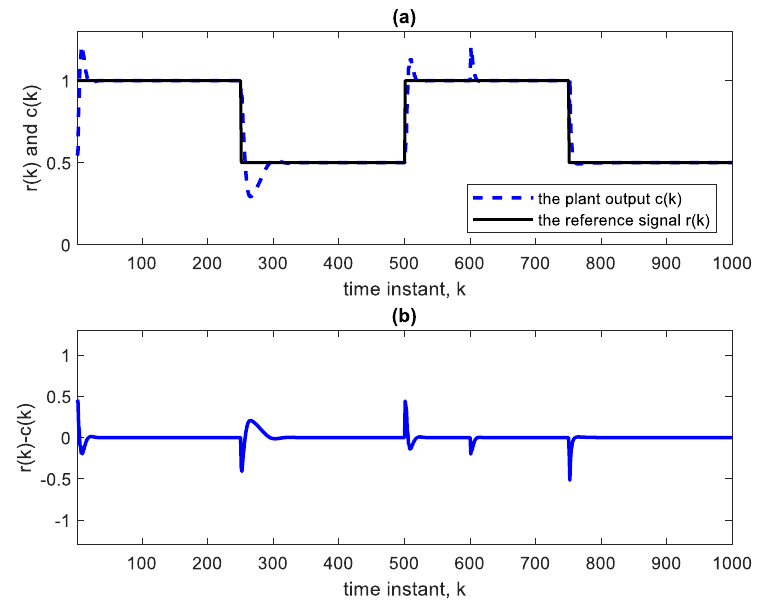
Figure 8. ( a ) Reference and plant output with a parameter change at the 600th sample according to Equation (8), using Ɲ (𝟒,𝟏):𝟓:𝟓:𝟓:𝟓 . ( b ) Error curve r(k)-c(k).